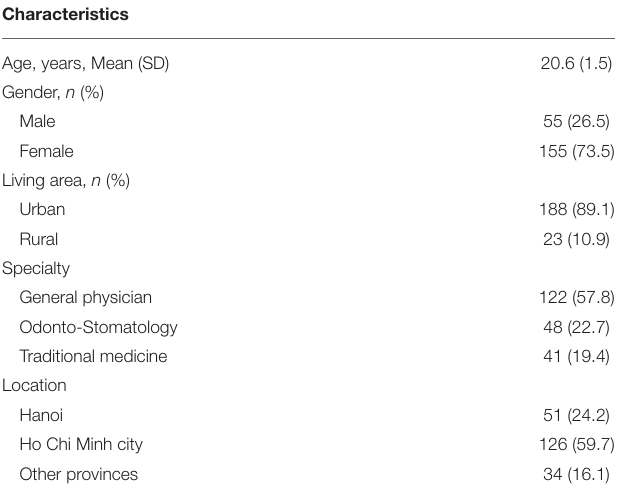
TABLE 3 | Correlation of latent variables and square root of AVE of each construct ( n =